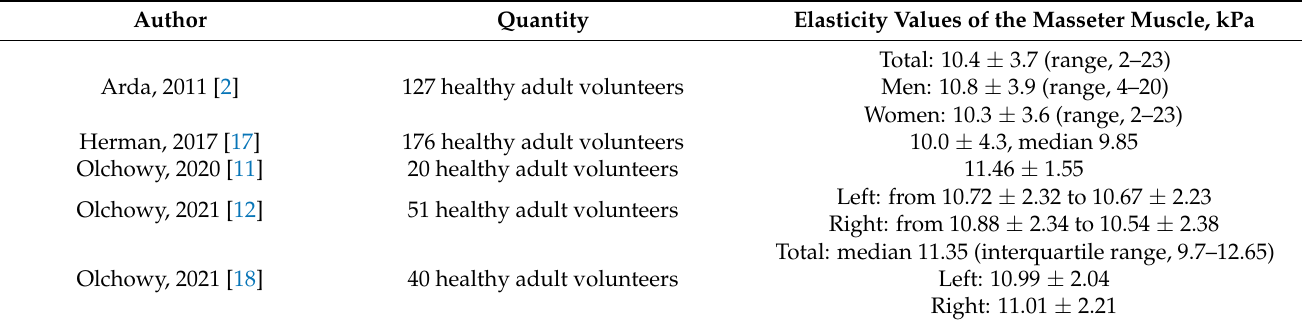
Table 2. Values of masseter muscle (expressed in kPa) stiffness from previous studies measured with the Aixplorer device.